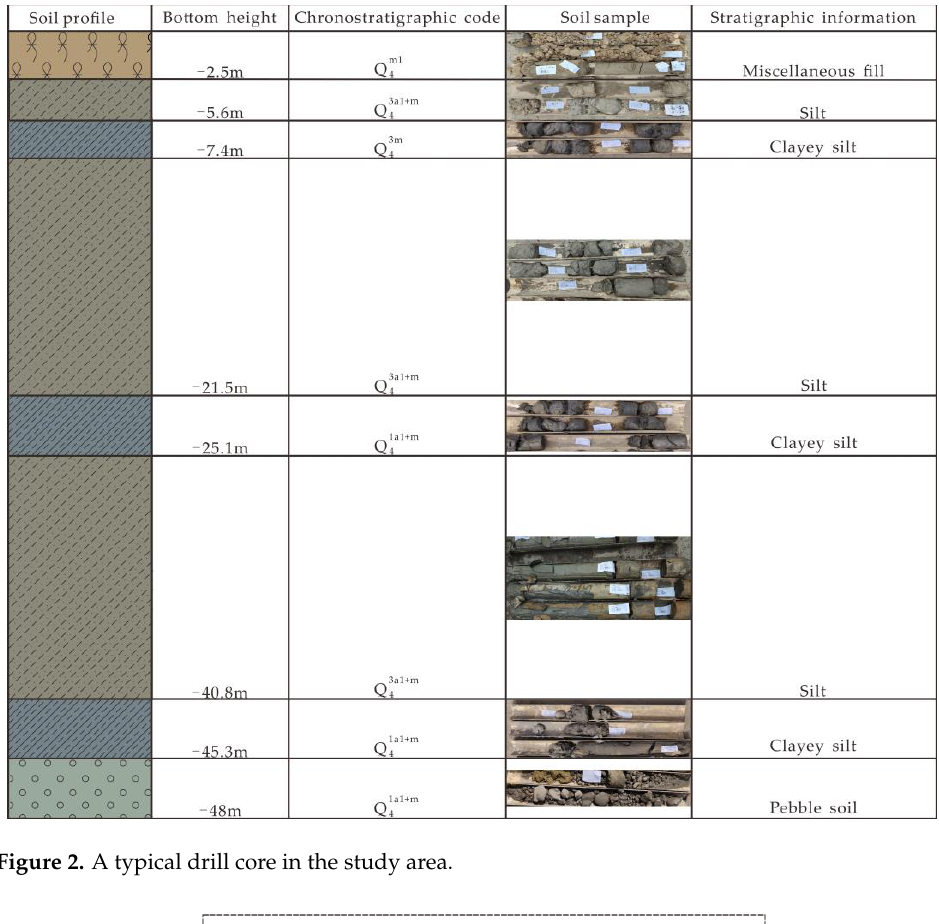
Figure 2. A typical drill core in the study area.